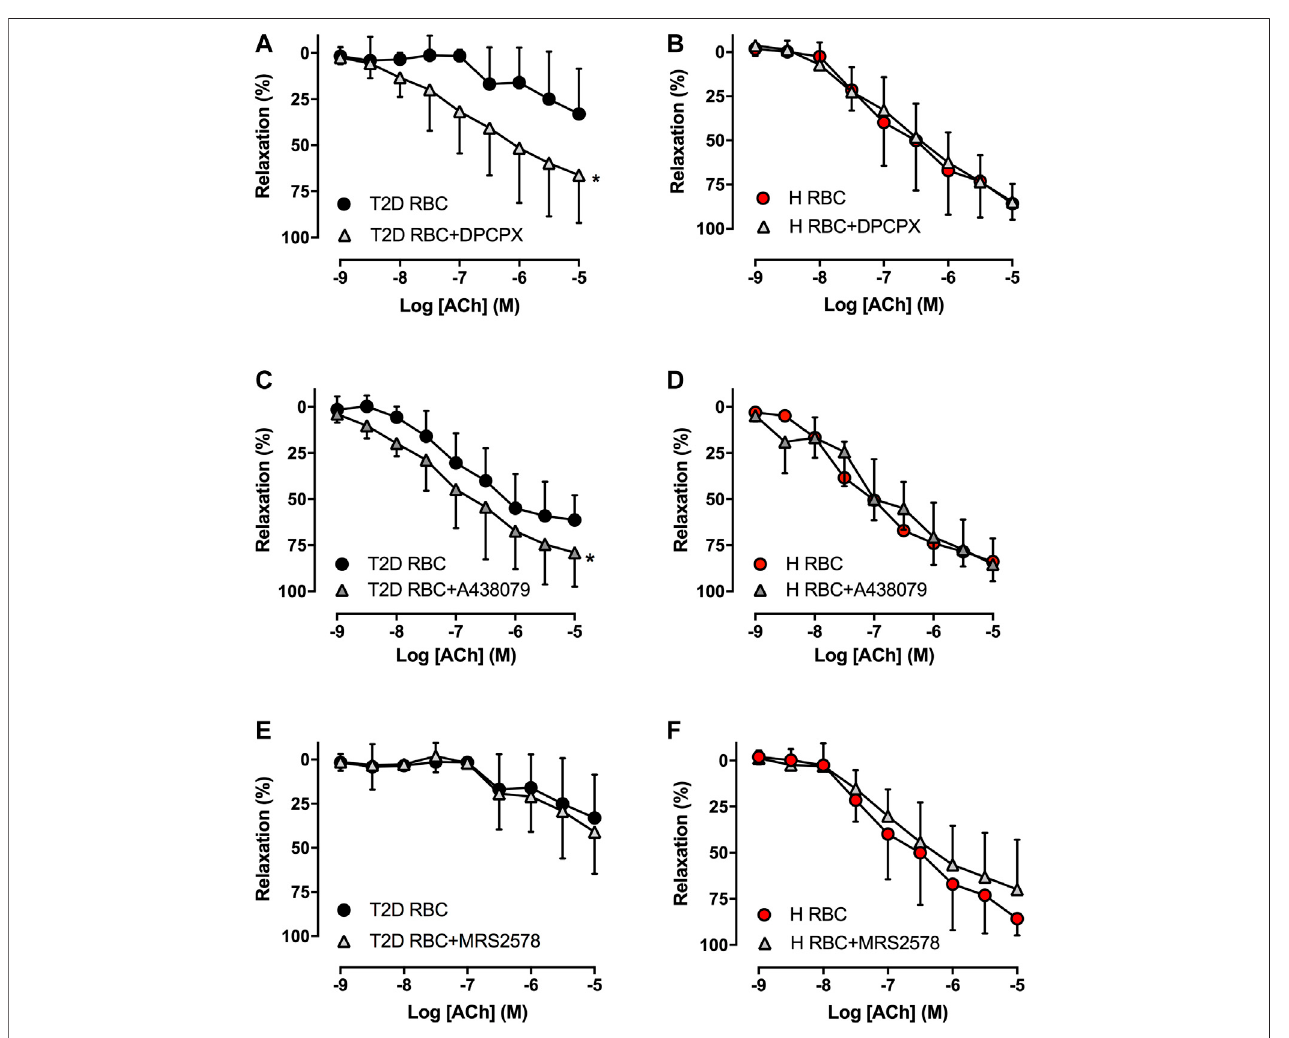
FIGURE 2 | Effect of the A1R antagonist DPCPX, the P2X 7 R antagonist A438079 and the P2Y 6 R antagonist MRS2578 on EDR in rat aortas incubated with T2D RBC ( A : n (cid:1) 8, C : n (cid:1) 4, E : n (cid:1) 7-8) or H RBC ( B : n (cid:1) 4, D : n (cid:1) 5, F : n (cid:1) 4). Values are mean ± SD. * p < 0.05 effect of antagonist.